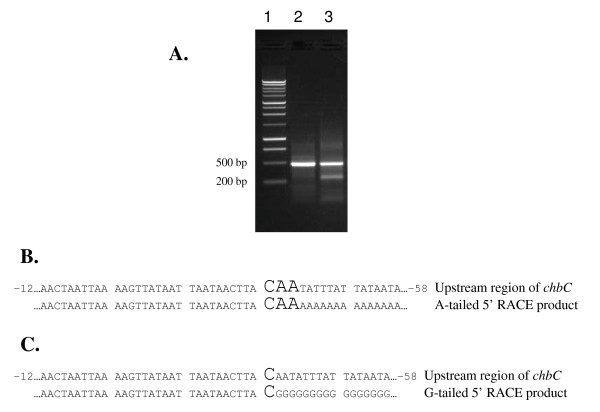
Determination of the chbC transcriptional start site. The chbC transcriptional start site was determined by 5' RACE analysis. (A) One percent TAE agarose gel of the 5' RACE products. A 1 kb ladder was used as a size standard (lane 1) for comparison of 5' RACE products (lane 2, dA-tailed product; lane 3, dG-tailed product). (B) DNA sequence of the dA-tailed 5' RACE product showing the ambiguous chbC transcriptional start site (enlarged font). (C) DNA sequence of the dG-tailed 5' RACE product showing the chbC transcriptional start site (enlarged font). Sequences were determined using the anti-sense primer BBB04 5' RACE R2.